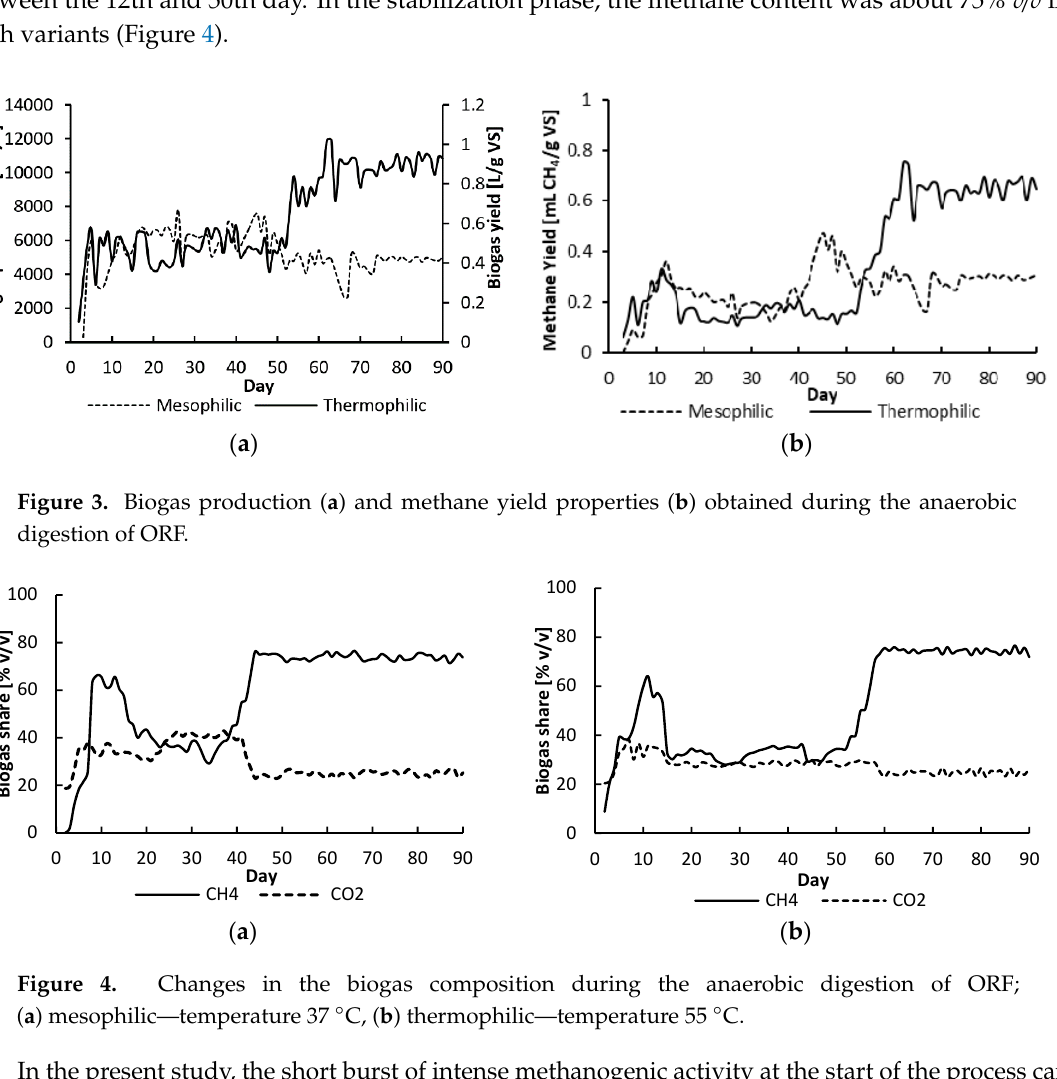
Figure 3. Biogas production ( a ) and methane yield properties ( b ) obtained during the anaerobic digestion of ORF.